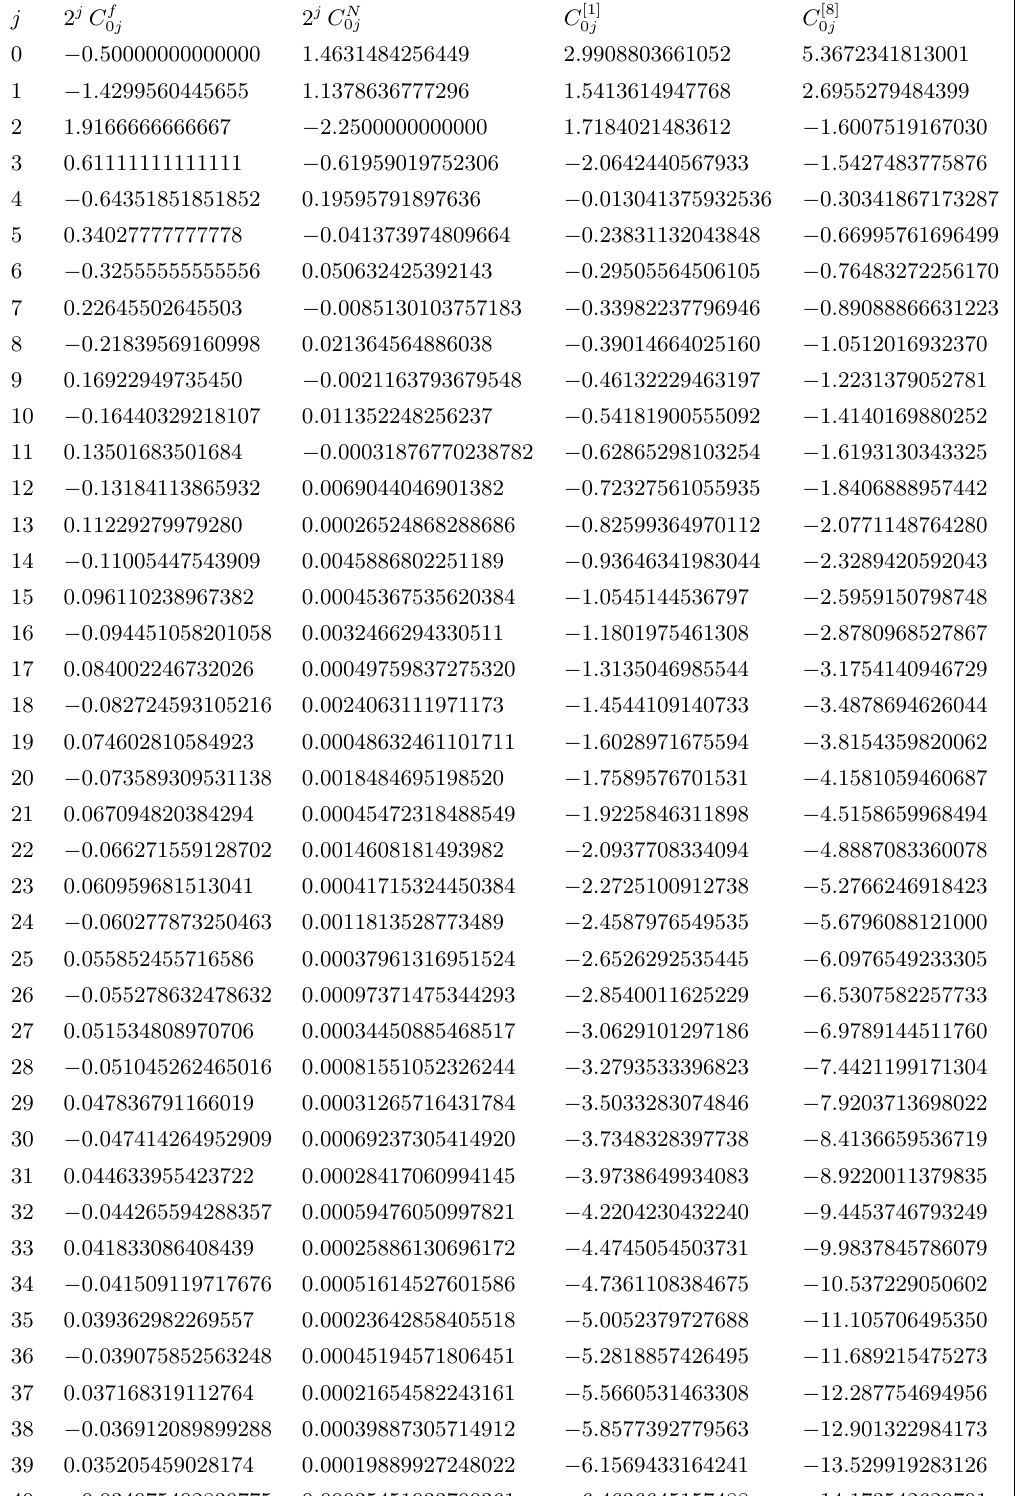
Table 10 . Coe(cid:14)cients of the term including ln 0 (1 (cid:0) z ) in the asymptotic expansion at z =